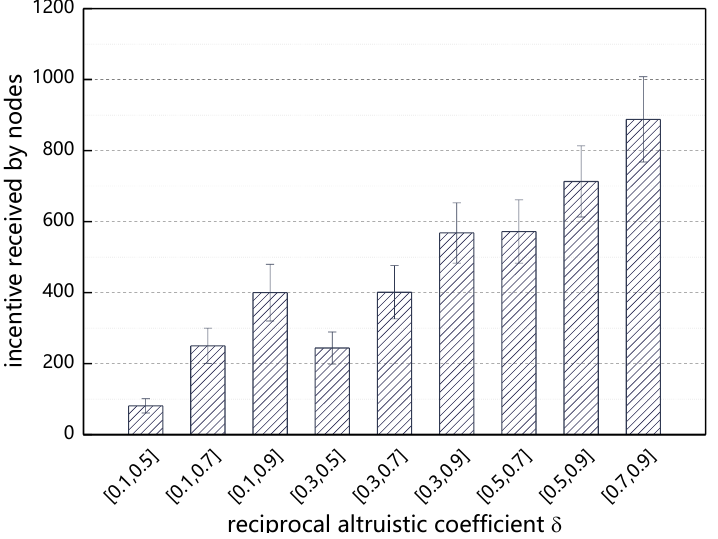
Figure 14. Incentive received by nodes with respect to δ .